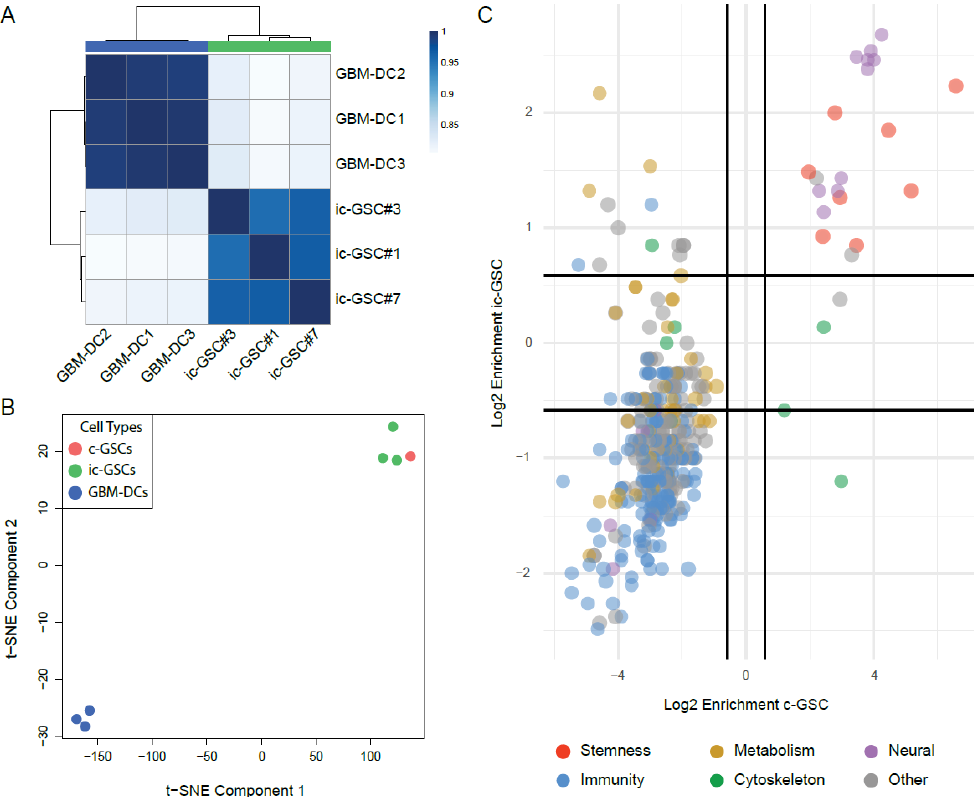
Figure 3. Transcriptomic analysis of induced core glioma stem cells. ( A ) Correlation matrix for three GBM-DC replicates and three ic-GSC lines based on gene expression profiles. ( B ) t-SNE plot of three GBM-DC replicates (blue), three ic-GSC lines (green), and a representative centroid of the c-GSC population (red) using gene expression profiles ( C ) Scatter plot of enriched pathways in representative ic-GSC and c-GSC populations and colored based on their biological network classification. GBM-DC replicates: GBM-DC1, GBM-DC2, and GBM-DC3; ic-GSC lines: ic-GSC#1, ic-GSC#3, and ic-GSC#7.